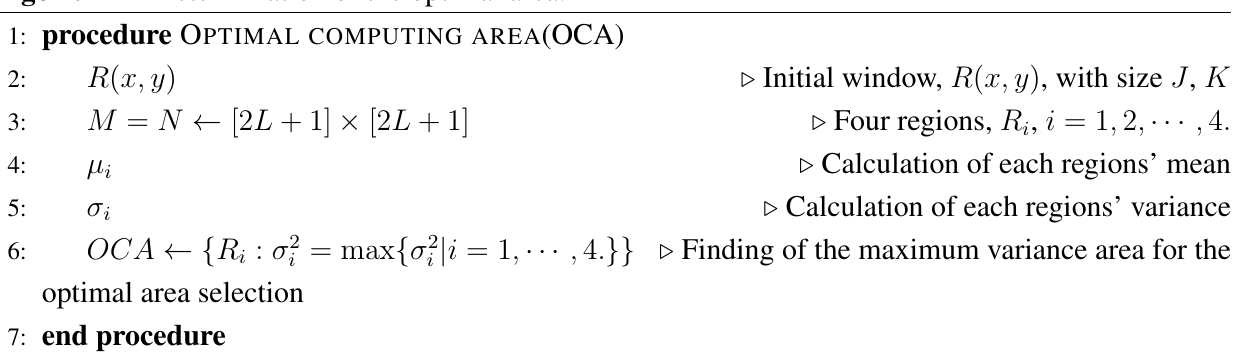
Algorithm 1 Determination of the optimal